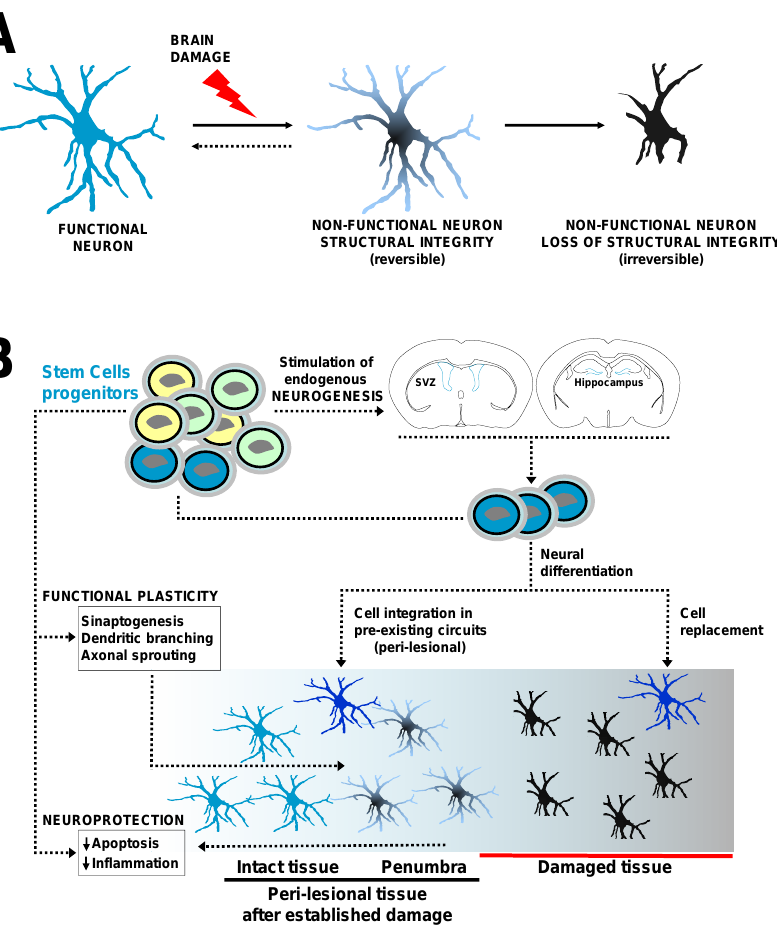
Figure 1. Stem cell mechanisms underlying recovery after cerebral damage. ( A ) After ischemic stroke, functional neurons (pre-ischemic; blue, left) go through different states including a reversible non-functional state called penumbra (black-blue, middle). If lack of blood flow